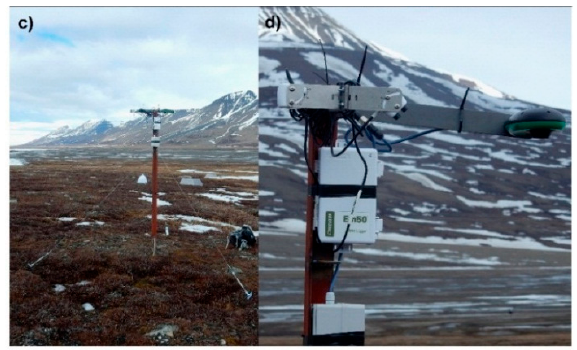
Figure 1. Maps of ( a ) location of the study area in Svalbard; ( b ) sensor locations in Adventdalen, Central Svalbard; ( c ) and ( d ) images of the Decagon Normalized Difference Vegetation Index (NDVI) surface reflectance sensor, hemispherical sensor and red-green-blue wavelength (RGB) camera. The black symbol in ( a ) shows the location of the study site in Svalbard and in ( b ) the locations of the six monitoring sites in Adventdalen. Rivers are indicated in blue in ( a , b ) and contour lines with elevations (masl) are also displayed in ( b